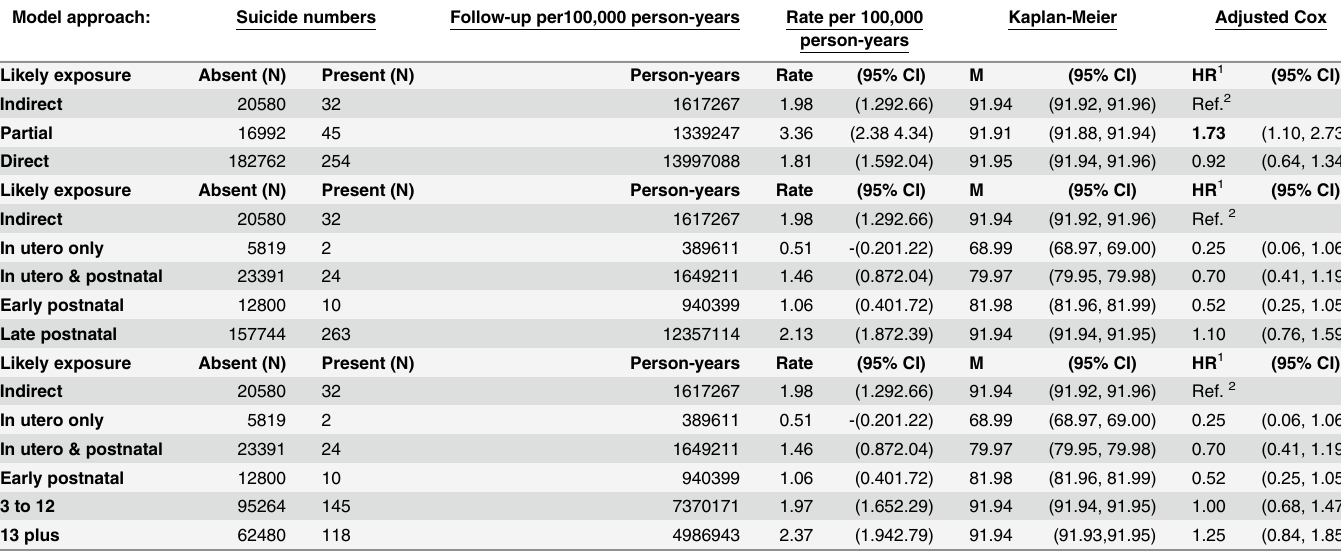
Table 1. Maximal adversity exposure groups and the risk of